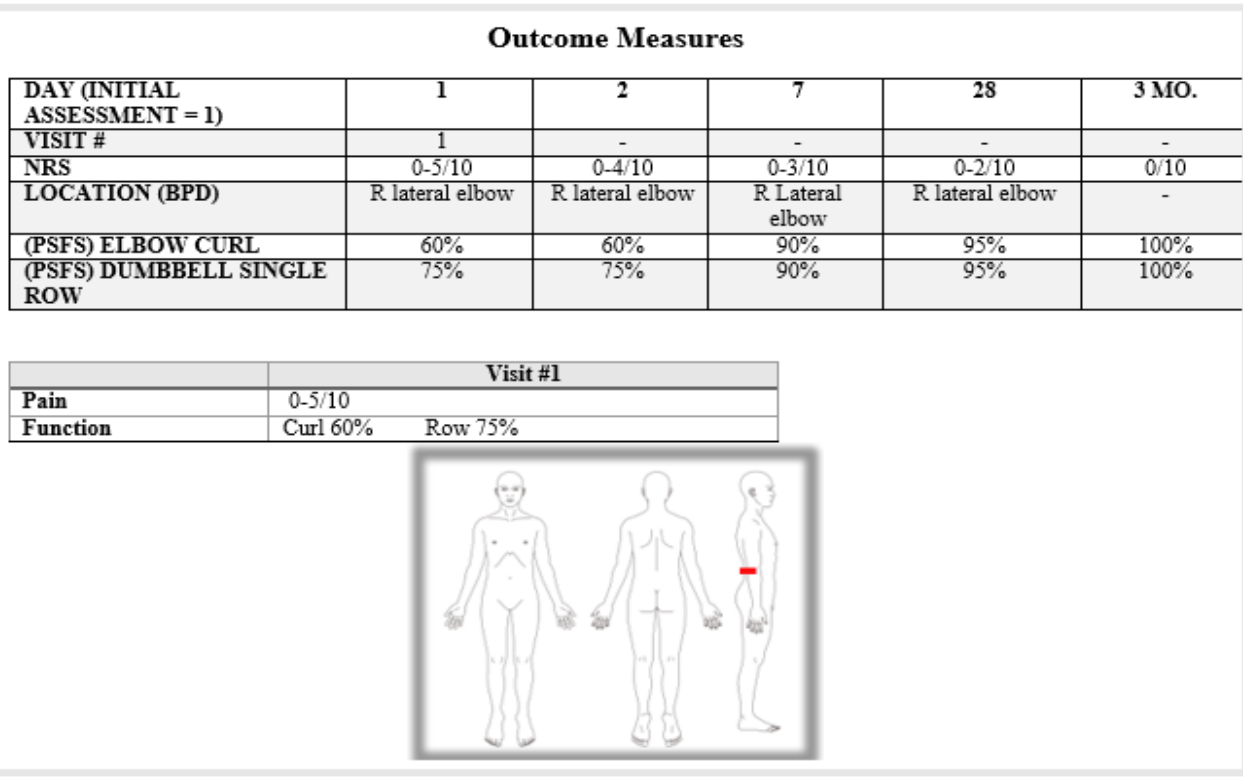
Table 6: Patient # 3: Right Lateral Elbow